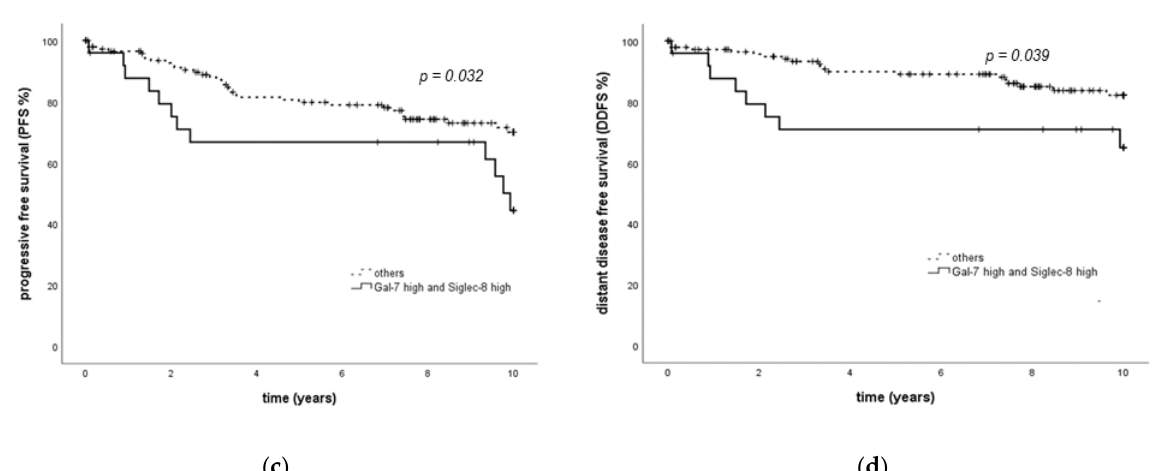
Figure 4. PFS and DDFS in subgroups defined by the combination of Gal-7 and Siglec-8 expression. Kaplan–Meier analyses of PFS ( a , c ) and DDFS ( b , d ) in subgroups defined by Gal-7 and Siglec-8 expression are shown. In Siglec-8-positive patients, PFS and DDFS differ significantly regarding Gal-7 expression ( a , b ), whereas Gal-7 was not significantly associated with PFS and DDFS in Siglec-8-negative patients. Patients in the “Gal-7 high/Siglec-8 high” showed a significantly impaired PFS ( c ) and DDFS ( d ) compared to all other subgroups. PFS = progression-free survival. DDFS = distant disease-free survival. Gal = galectin. IRS = immune reactivity score.